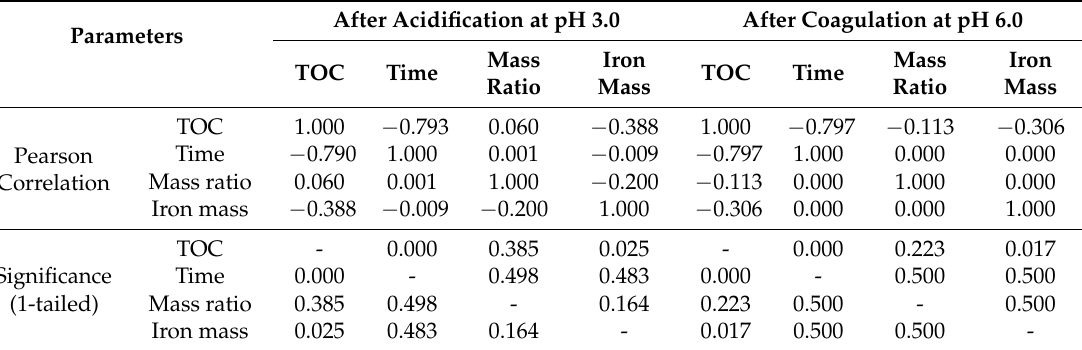
Table 3. Correlation factors for the Fe 0 /H 2 O 2 process.